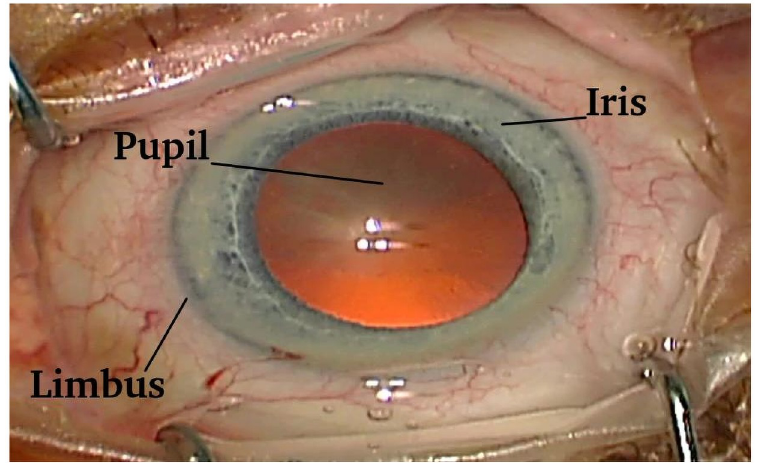
Fig 3. Structure of the human